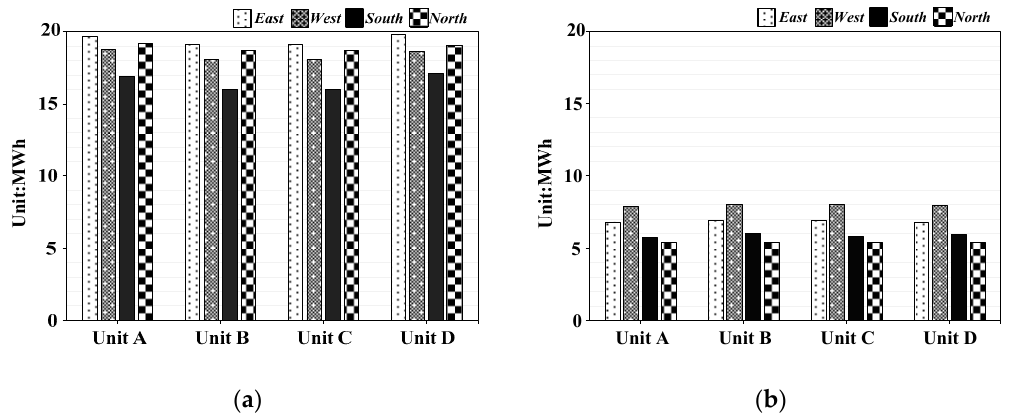
Figure 3. The effect of building orientations on building energy consumptions. ( a ) Heating loads; ( b ) Cooling loads.